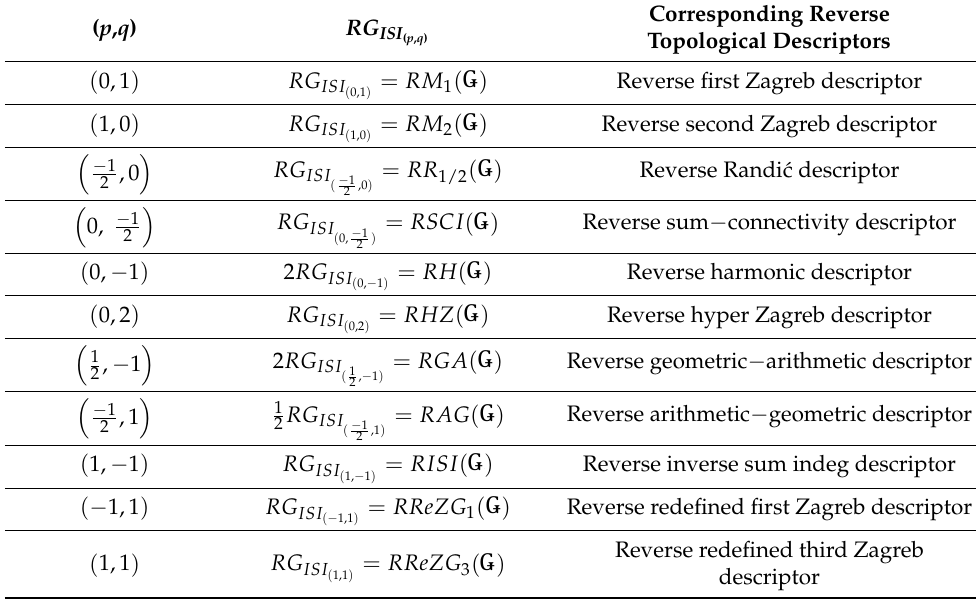
Table 1 Some reverse degree-based topological descriptors derived from the reverse general inverse sum indeg descriptor by assigning specific values to the parameters p and q .